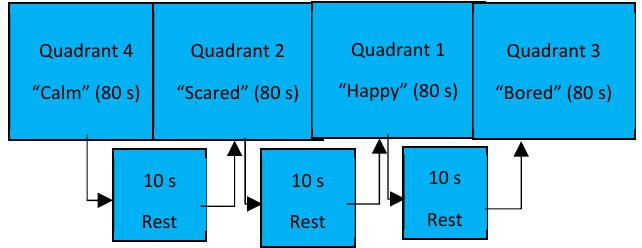
Figure 3. Video sequence of the VR stimulus.